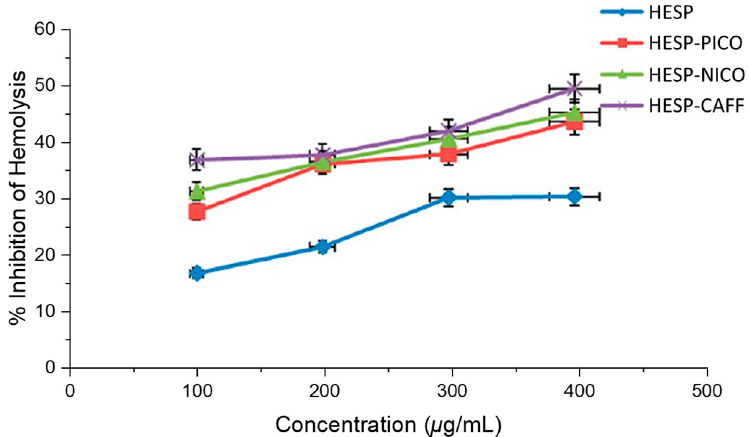
Figure 13. Percentage inhibition of oxidation of DPPH radical by hesperidin and the cocrystals. Adapted from [72] with permission. Copyright © 2017 American Chemical Society.